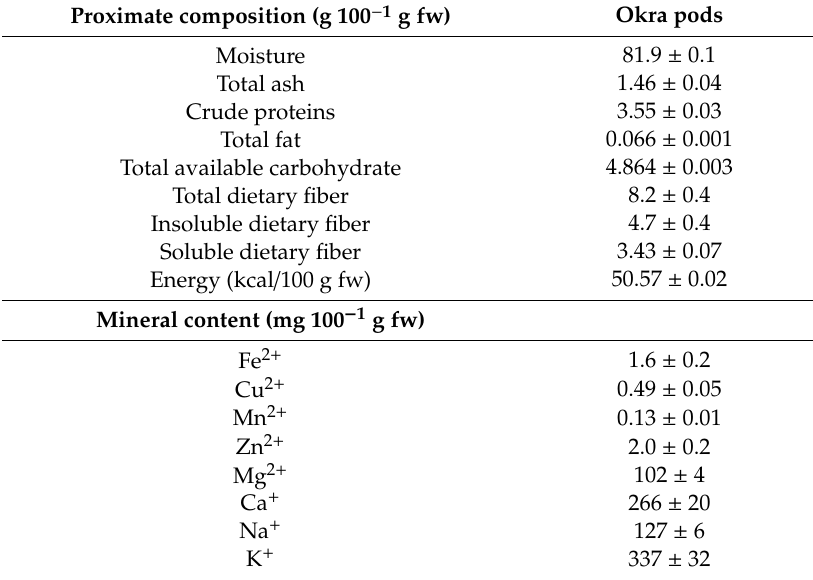
Table 1. Proximate composition (g 100 − 1 g fw) and mineral content (mg 100 − 1 g fw) of the studied okra pods (mean ±